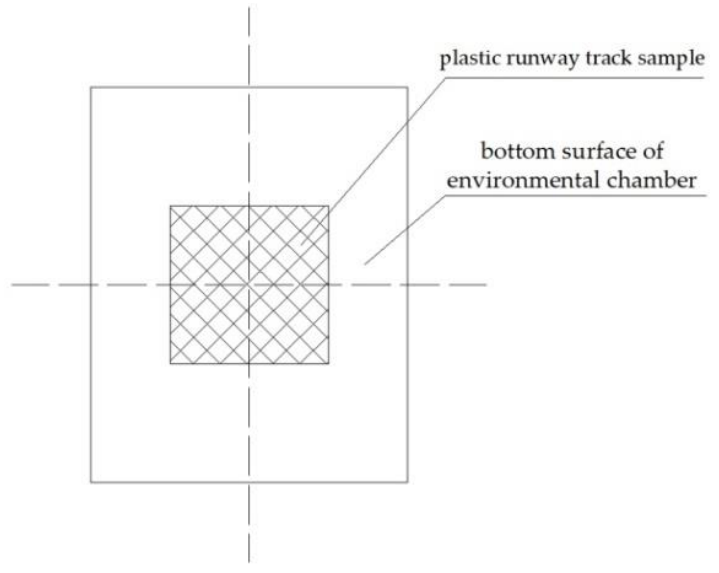
Figure 3. Specific parts of the plastic track sample placed in the environmental chamber.